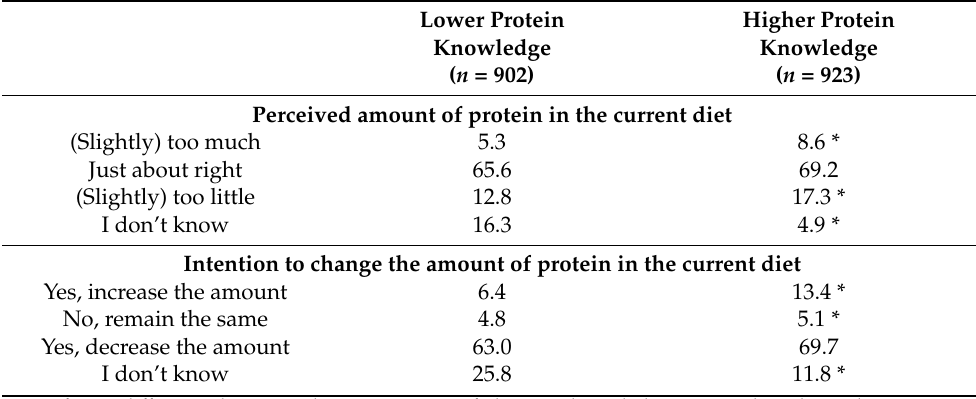
Table 4. Perceived amount of protein in the current diet and intention to change the amount of protein in the current diet by the two protein knowledge level groups ( n = 1825).